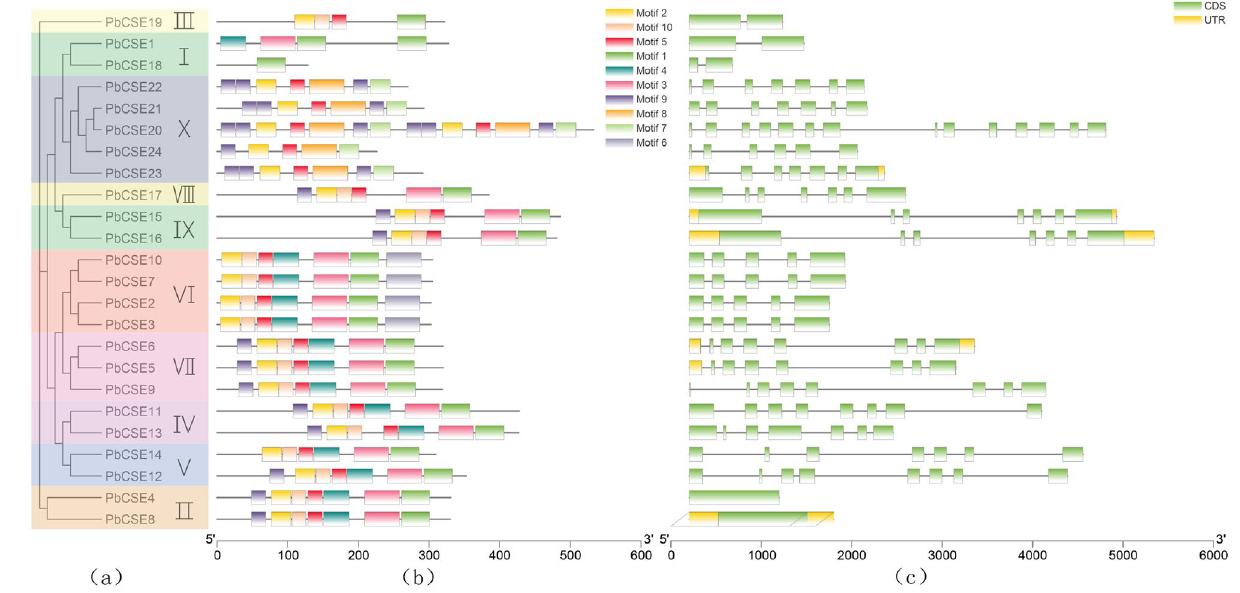
Figure 2. Gene characteristic analysis and chromosome localization of PbCSE proteins. ( a ) Phylogenetic analysis of PbCSE proteins. ( b ) The conserved motifs of PbCSEs based on their evolutionary relationships. ( c ) The gene structures of PbCSEs based on their evolutionary relationships.